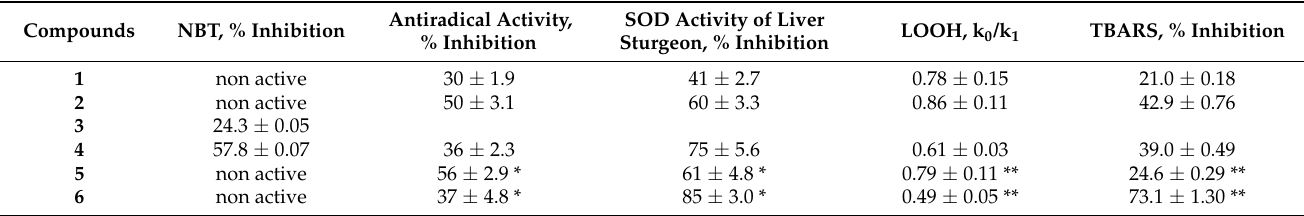
Table 3. Antiradical capacity indicators of compounds 1 – 6